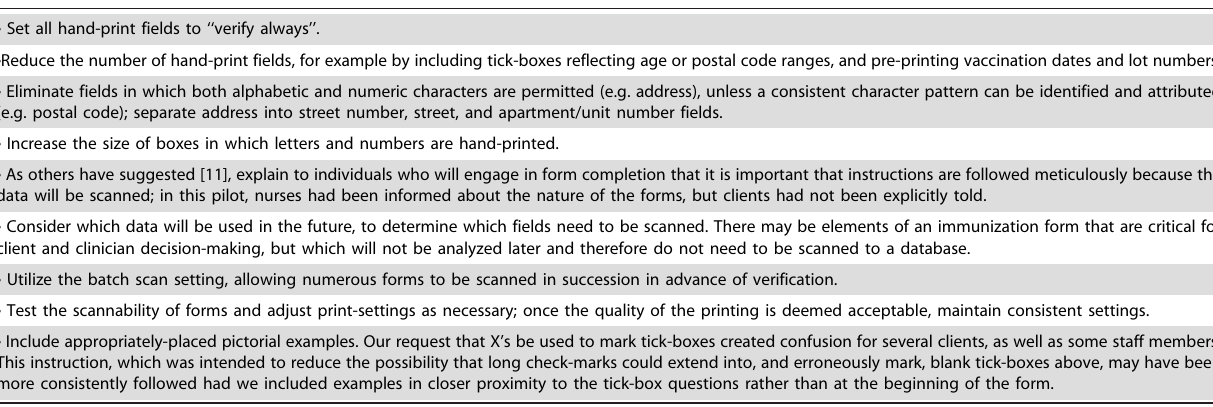
Table 3. Recommendations to Enhance